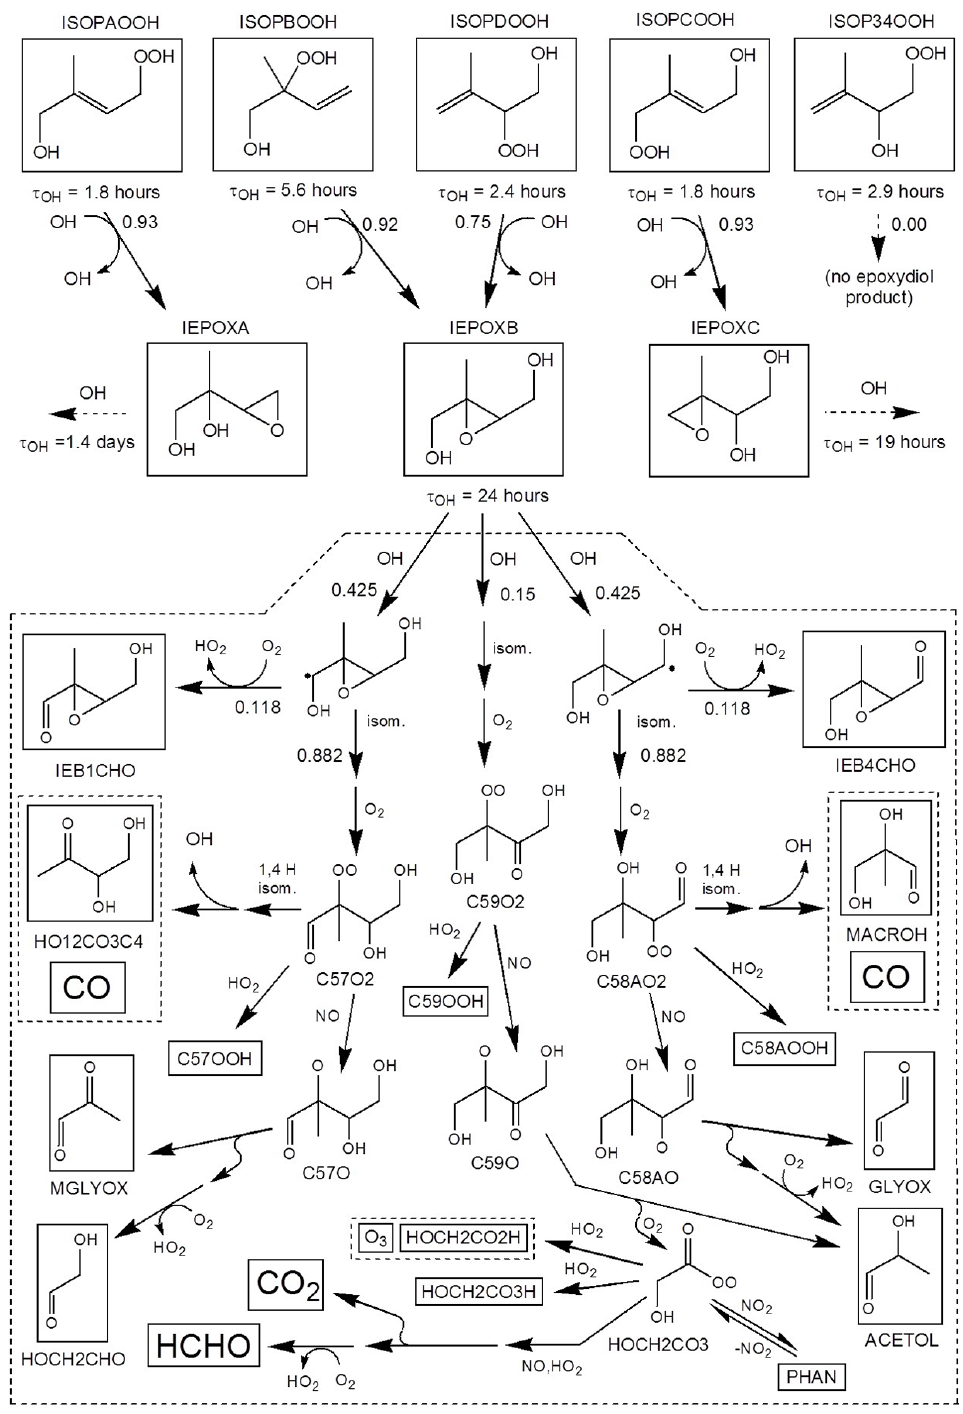
Figure 8. Overview of the OH-initiated degradation of isoprene hydroxy-hydroperoxides, as represented in MCM v3.3.1. The dominant formation of the isomeric epoxydiol products is shown, with the further degradation of the most abundant isomer, IEPOXB. For clarity, the terminating reactions of peroxy radicals with NO and the reactions of peroxy radicals with NO 3 and the peroxy pool are not shown. Representative lifetimes ( τ OH ) for reactions with OH are shown, based on [OH] = 10 6 moleculecm − 3 .